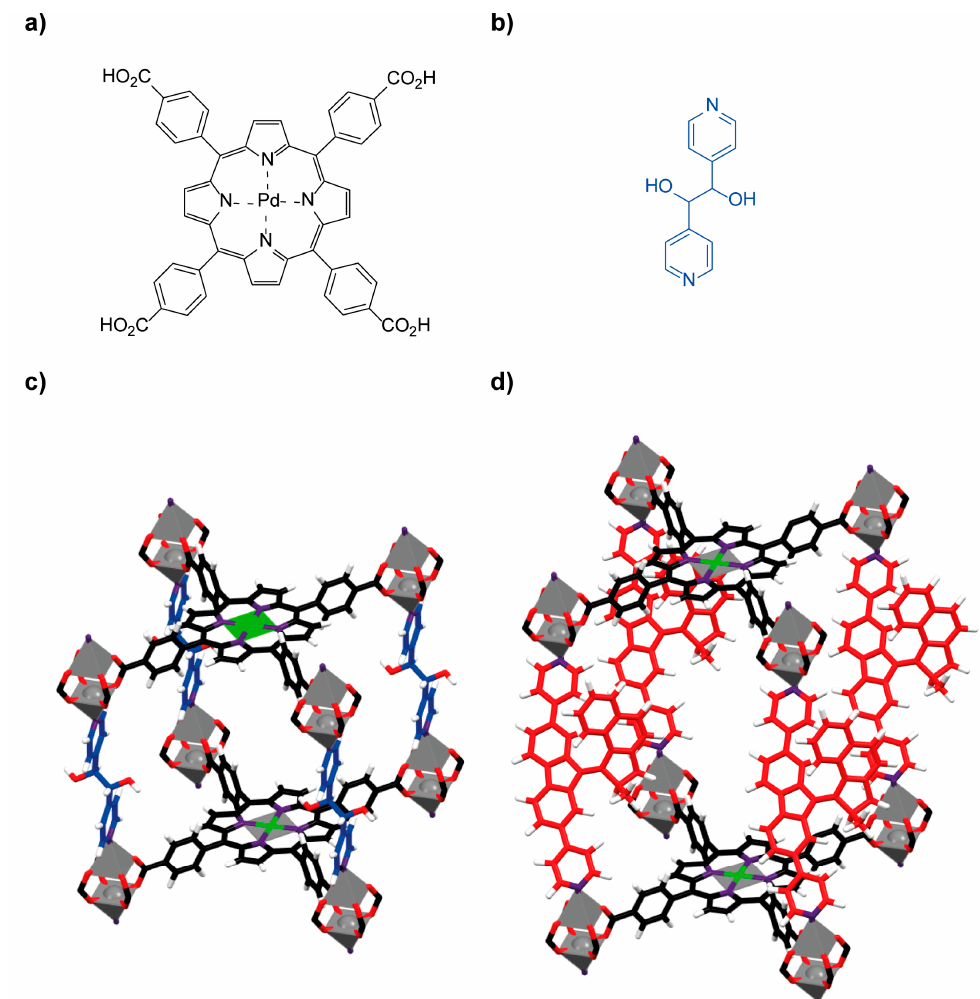
Figure 14. ( a ) Chemical structure of porphyrin-based photosensitizer strut 14 ; ( b ) structure of DPG pillars; ( c ) stick representation of the crystal structure of the PdTCPP-MOF showing a portion of the lattice framework; ( d ) simulated stick schematic representation of the moto-MOF3 containing the overcrowded alkene-based molecular rotor 13a as organic linker [87]. Color key: grey = zinc atoms; grey with green lines = palladium atoms; black = carbon atoms of the photosensitizer ligand 14 ; blue = DPG carbon atoms; red = oxygen atoms and carbon atoms of the overcrowded alkene-based molecular motor linker 13a ; white = hydrogen atoms; purple = nitrogen